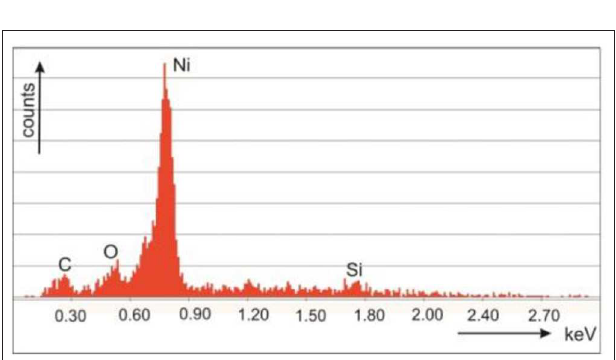
FIGURE 3 | EDX-spectrum taken at the pore bottom of a cross-section of a Ni filled microporous silicon sample. Granitzer et al. [47], with